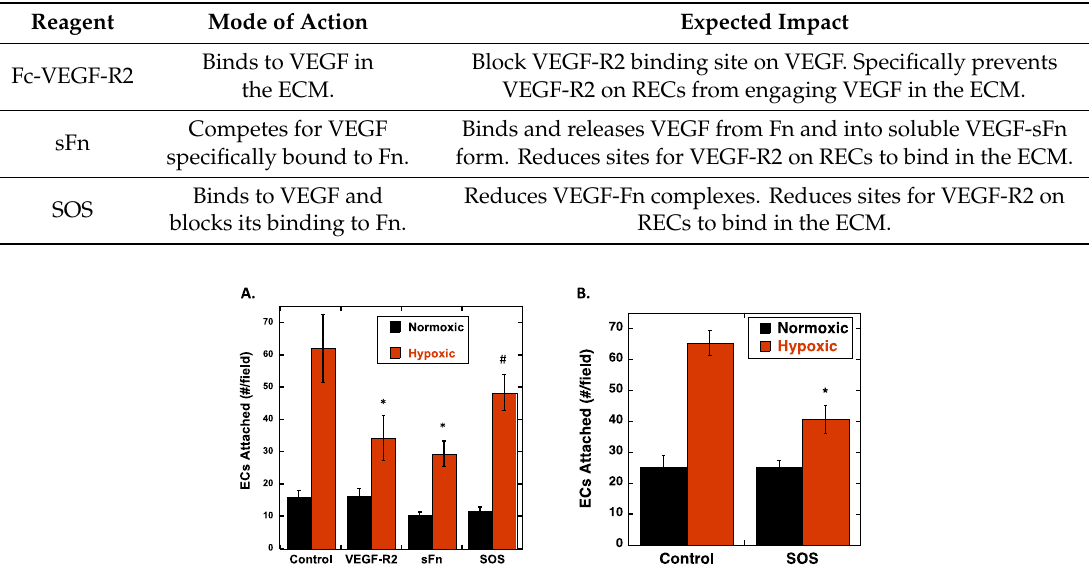
Table 1. Summary of VEGF-ECM Antagonists.